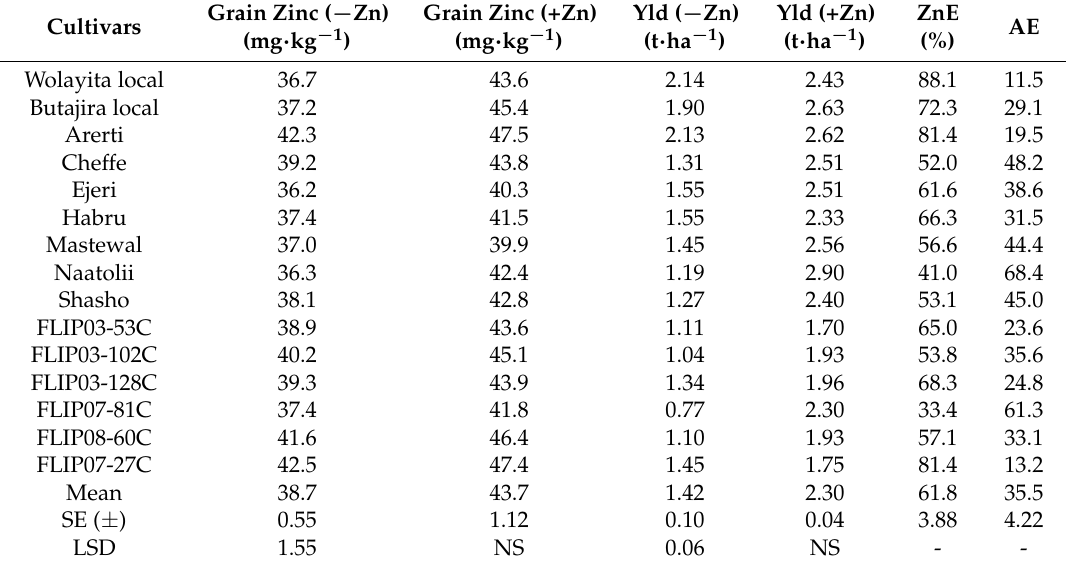
Table 7. Grain zinc concentration (mg · kg − 1 ), zinc efficiency (ZnE), and agronomic efficiency (AE) of 15 chickpea cultivars and breeding lines tested with (+Zn) and without zinc ( − Zn) fertilizer application over the locations in 2012 and 2013.